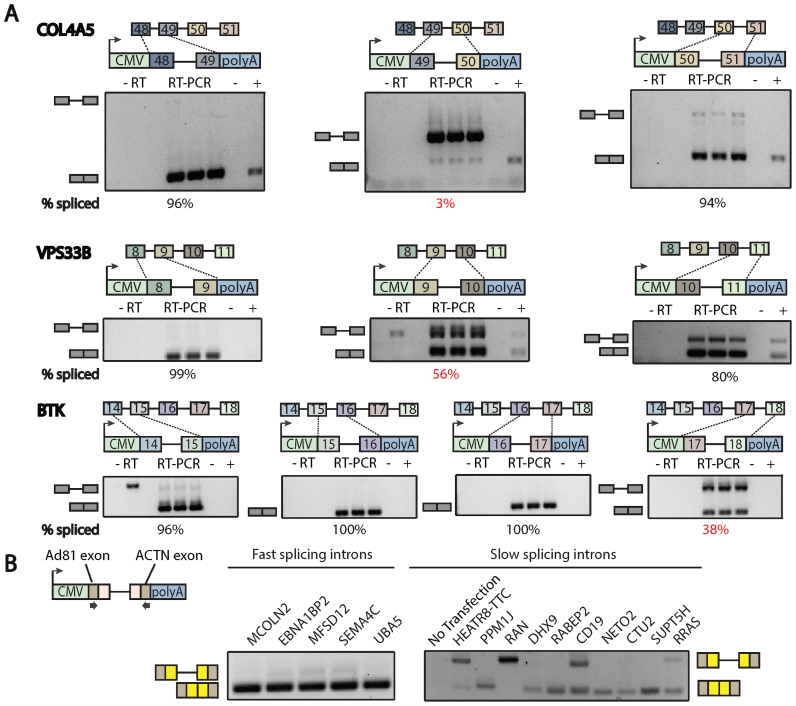
Always-last splicing introns are likely show lower splicing efficiency in a single intron mingene construct. (A) Introns that were affected by the mutations and their flanking exons were individually cloned into the Plasmid pzW4 using BamH1 and Nhe1 cloning site. Plasmid-specific forward primer was used to amplify only the construct, not endogenous sequences. Negative control was total 293 cDNA without transfection amplified using specific primers. Positive control was total cDNA amplified using endogenous sequence targeting primers. Introns close to the reported mutations showed lowest splicing efficiency among neighbors (Intron 49 of COL4A5 gene/Intron 9 of VPS33B gene and Intron 17 of BTK gene). (B) Always-last splicing introns showed lower splicing efficiency in minigene construct. Five introns that splice first more than 90% of the time and 10 introns that always splice last among neighbors in the genome-wide screen were selected and cloned into minigene constructs. Always-first splicing introns showed high splicing efficiency whereas always-last splicing introns showed varying splicing efficiency.